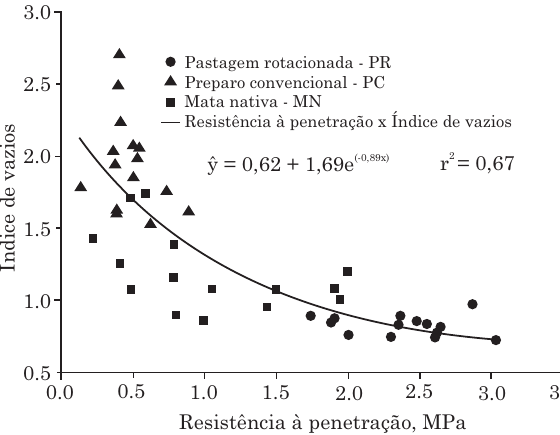
Figura 4. Relação entre o índice de vazios e a resistência à penetração do solo, em três sistemas de uso do